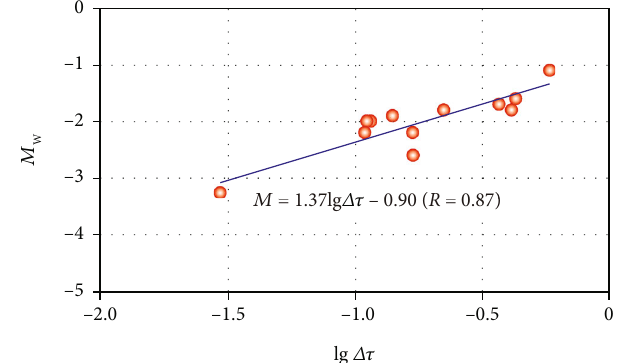
Figure 5: Relationship between the stress drop and the earthquake magnitude of the left bank slope of the Jinping-1 hydropower station. Red dots represent the twelve microseismic events that occurred along the locked